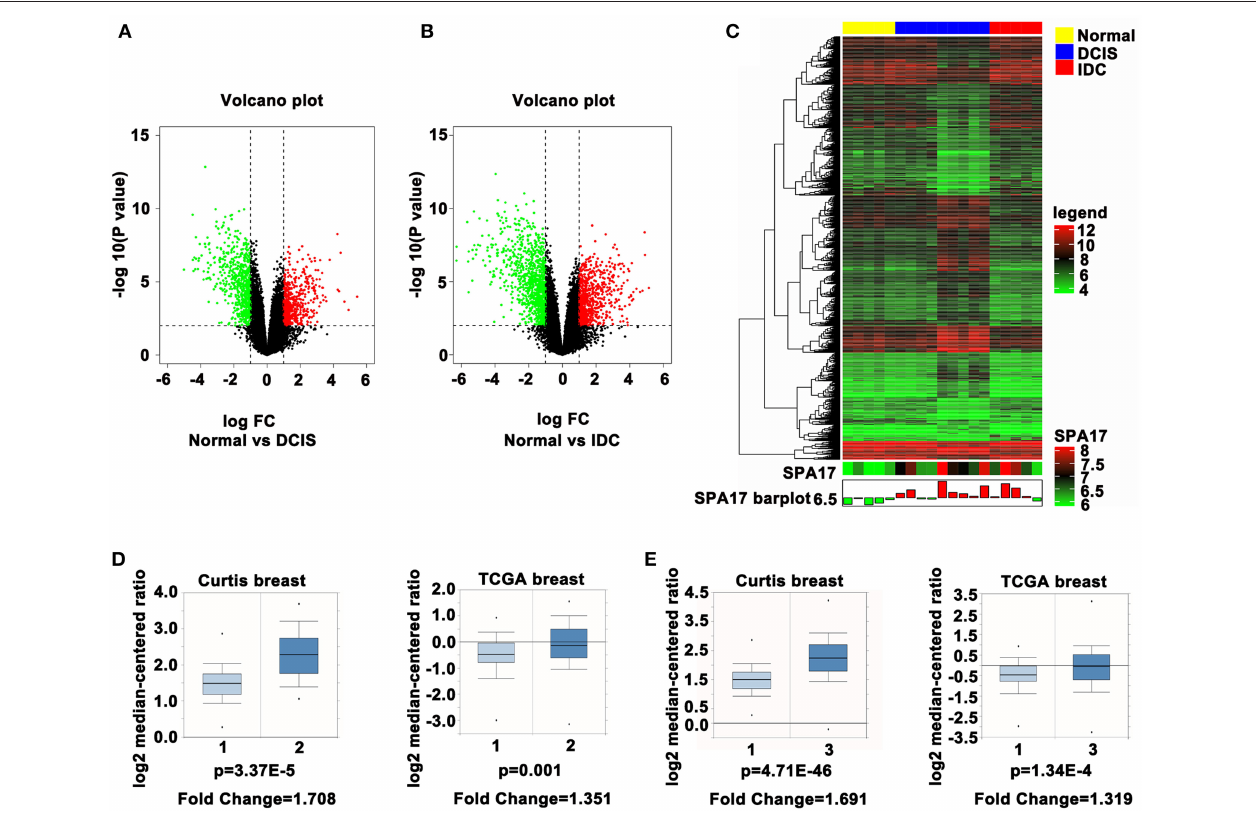
FIGURE 1 | (A) The volcano plot of SPA17 expression in DCIS vs. normal breast tissues and (B) IDC vs. normal breast tissues (DCIS = ductal carcinoma in situ , IDC = invasive ductal carcinoma). (C) Heatmap plot of SPA17 expression in breast cancer and normal breast tissues. (D) SPA17 expression in invasive breast carcinoma (2) vs. normal breast tissue (1) in Curtis ( p = 3.37E-5, fold change = 1.708) and in TCGA Breast Database ( p = 0.001, fold change = 1.351). (E) SPA17 expression in invasive ductal breast carcinoma (3) vs. normal breast tissue (1) in Curtis ( p = 4.71E-46, fold change = 1.691) and in TCGA Breast Database ( p = 1.34E-4, fold change =